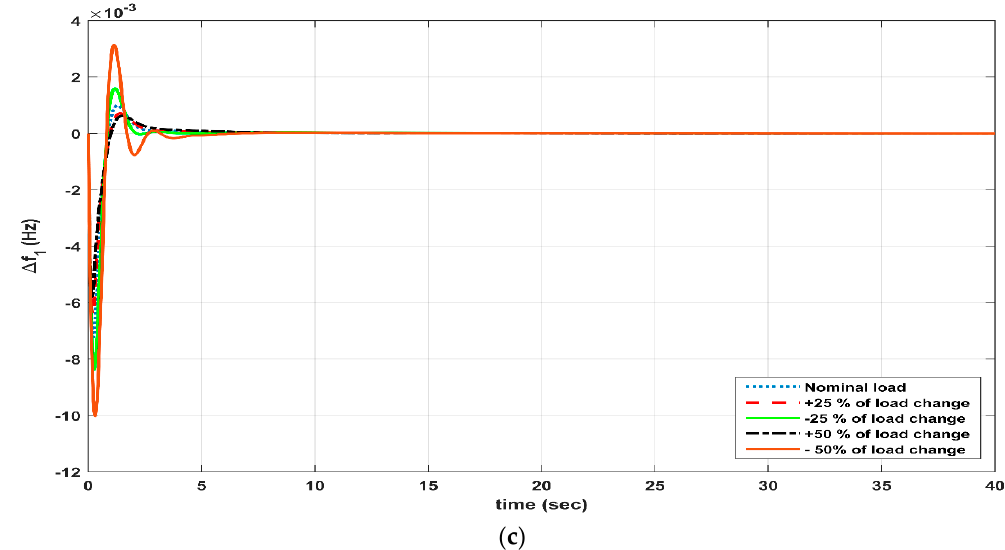
Figure 11. Different load change for the system considering ( a ) ∆ Ptie ( b ) ∆ F2 ( c ) ∆ F3. Table 4. Transient response computation for change in parameters of the power system.